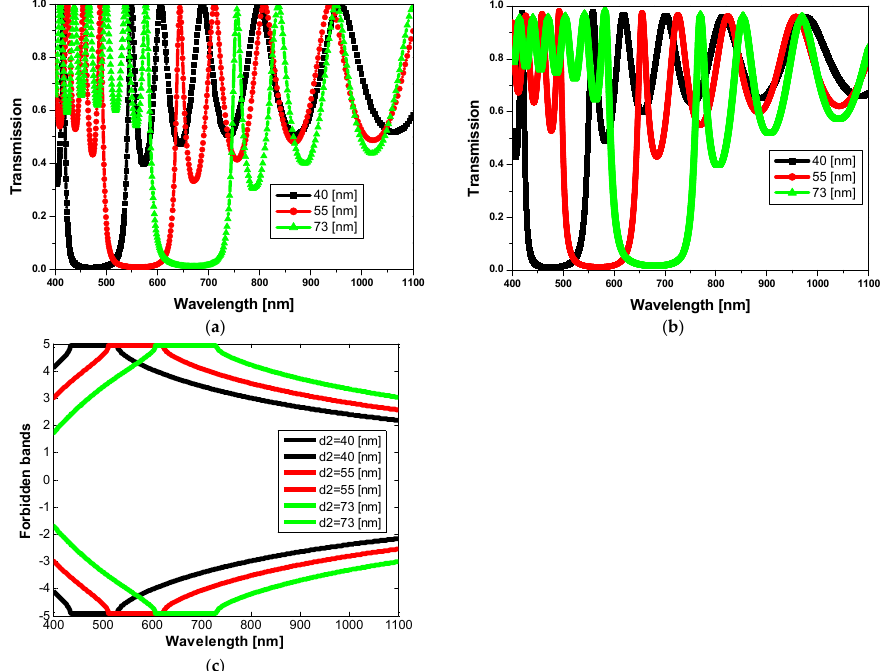
Figure 6. 1D binary photonic crystals of Bi 4 Ge 3 O 12 with thickness 62 𝑛𝑚 and μ c-SiO x : H with different thicknesses for ten periods as shown ( a ) by FDTD, ( b ) by TMM, ( c ) dispersion relation of the same structure by TMM.